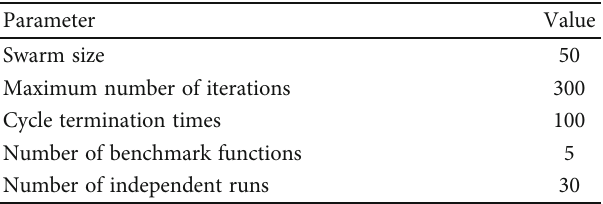
Table 2: Arti fi cial bee colony algorithm parameter setting.